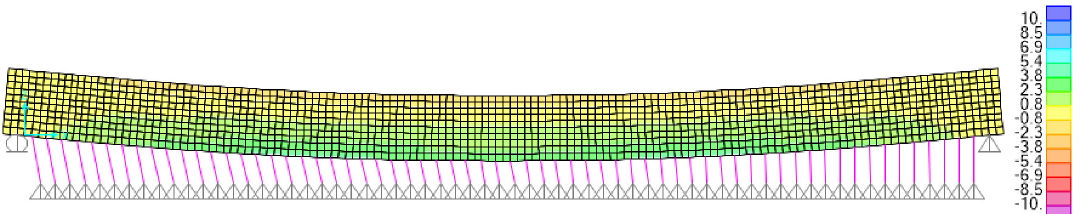
Figure 30. Tensile stress distribution in Span-2 for 50 mm-settlement scenario.